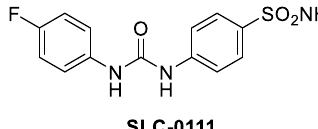
Figure 3 . The structure of SLC-0111, a specific hCA IX and XII inhibitor studied in phase Ib/II clinical trials for the treatment of hypoxic tumors.